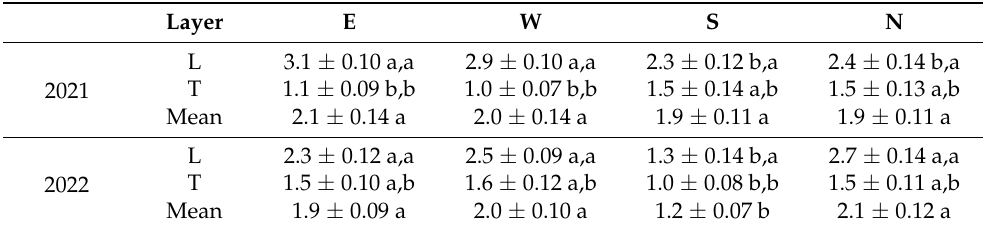
Table 2. LAI (m 2 m − 2 ) at DOYs 225 and 229, for years 2021 and 2022, respectively, in different expositions (E, W, S, N) for different layers: low (L; 0.5–1.4 m) and top (T; 1.4–2.3 m). The first letters denote statistical differences among row orientations; the second letters denote statistical differences between layers ( p = 0.05; SNK